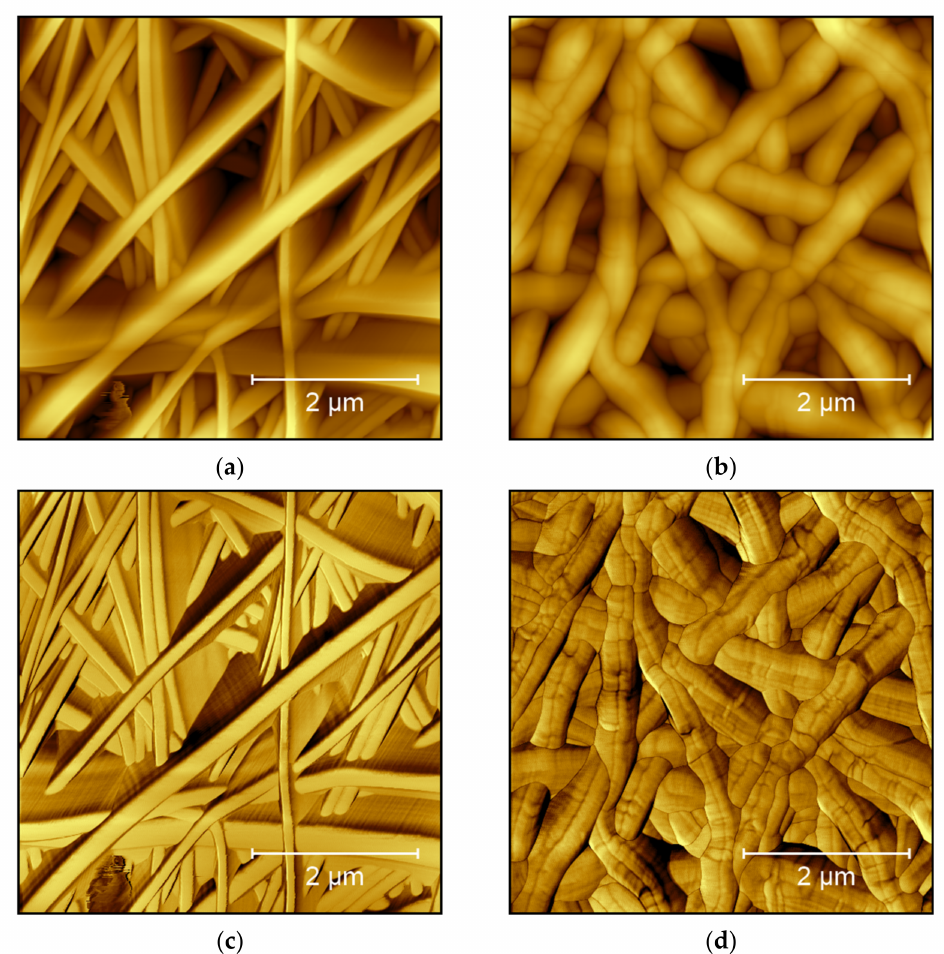
Figure 4. AFM images taken on poly(acrylonitrile) (PAN) nanofiber mats: ( a ) raw mat, topography image; ( b ) hot-pressed mat, topography image; ( c ) raw mat, phase image; and ( d ) hot-pressed mat, phase image. Images taken with a Nanosurf FlexAFM with the following scanning parameters: 512 points × 512 lines, 1.4 s/line, setpoint 55%, p-gain 550, i-gain 1000, d-gain 100, free vibration amplitude 6